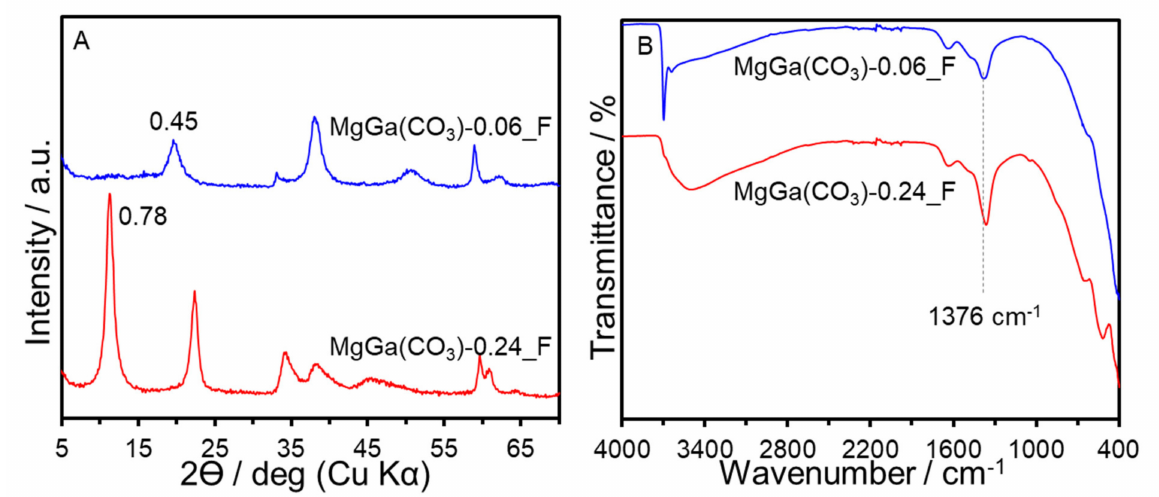
Figure 7. ( A ) XRD patterns and ( B ) IR spectra of MgGa(CO 3 )-0.24_F and MgGa(CO 3 )-0.06_F. Reconstruction of MgGa(CO 3 )-0.24_F and MgGa(CO 3 )-0.06_F were examined by the sulfate (SDS). The calcination of MgGa(CO 3 )-x_F (x = 0.24 and 0.06) at 500 ◦ C caused